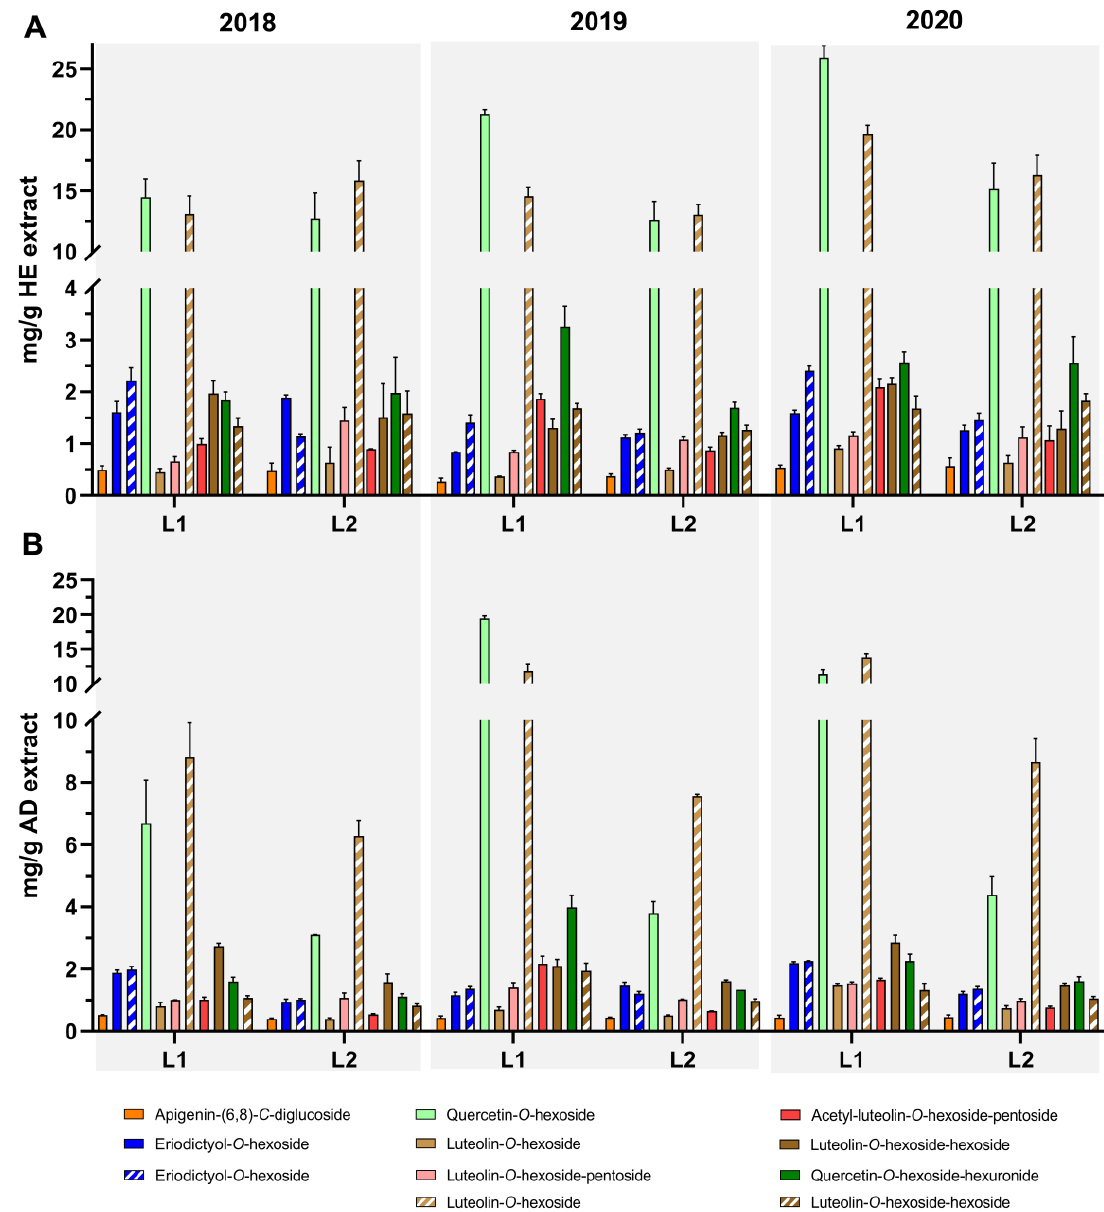
Figure 4. Annual variation (2018–2020 period) of individual flavonoids in T. carnosus hydroethanolic ( A ) and aqueous decoction ( B ) extracts obtained by HPLC-DAD analysis.